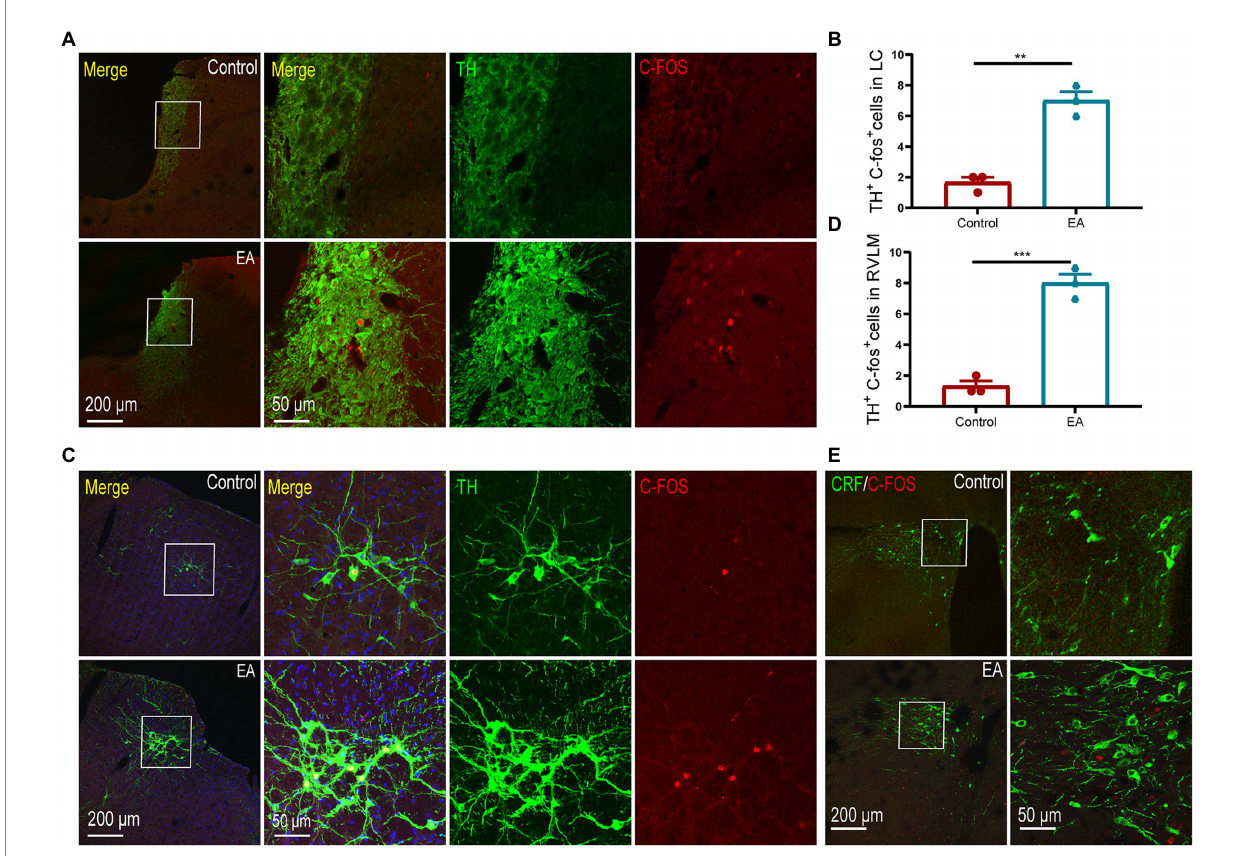
FIGURE 5 EA activated the neurons in the LC and RVLM. (A,B) TH + c-fos positive neurons in the LC increased after EA. (C,D) TH + c-fos positive neurons in the RVLM increased after EA. ** p < 0.01. (E) No co-expression of CRF + c-fos positive neurons was observed in the PVN of rats in the two groups. n = 4 in each